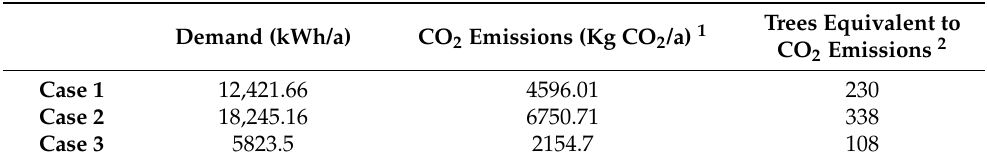
Table 9. Conversion of annual savings from kilowatt-hours to kilograms of CO 2 in the Barcelona case study.